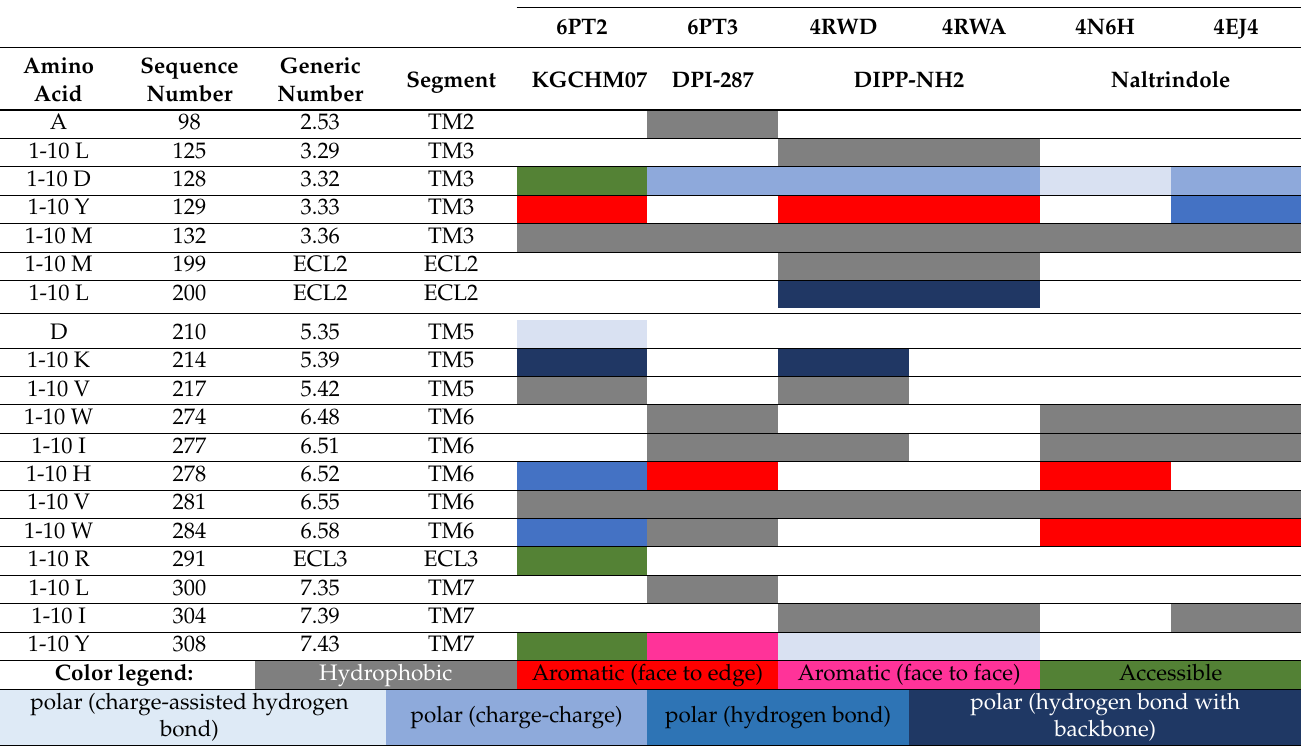
Table 2. Receptor-ligand interactions of the δ OR in complex with peptide and small-molecule agonists and antagonists. Table produced in part using the GPCRdb. [62,63]. This table does not reflect the full extent of receptor-ligand interactions, especially with regards to the involvement of the amino acid residues forming hydrophobic sub-pockets of the orthosteric site that are necessary for ligand binding. Additional amino acid residues such as Asp2.50, Asn3.35, and Ser3.39 which form the sodium binding site are also not included in this table. Agonist Antagonist 6PT2 6PT3 4RWD 4RWA 4N6H